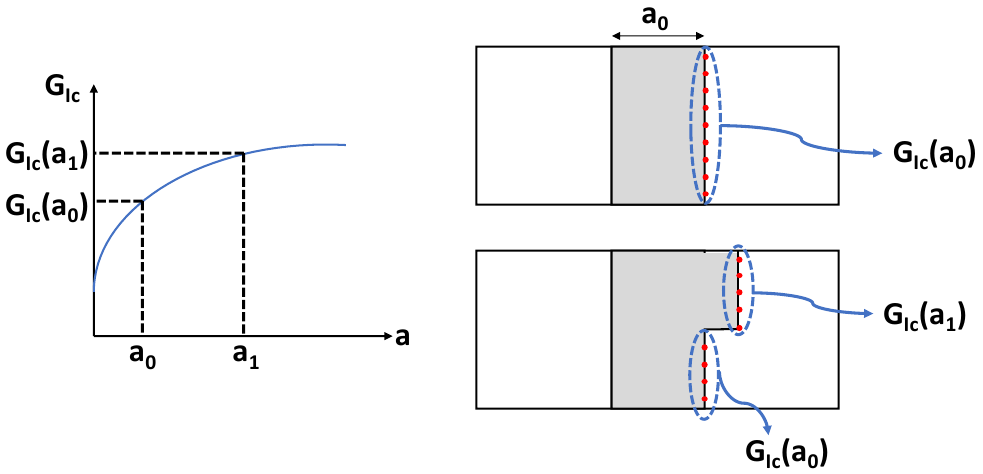
Figure 10. Description of the Fibre Bridging (FB) modulus operation based on the R-curve.